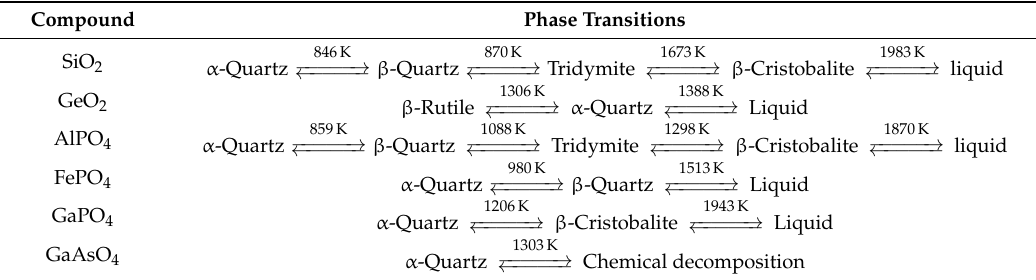
Figure 1. α -quartz structure of A O 2 ( A = Si, Ge) and MX O 4 ( M = Al, Ga, Fe and X = P, As) materials. Table 1. Polymorphism of the A O 2 and MX O 4 materials.